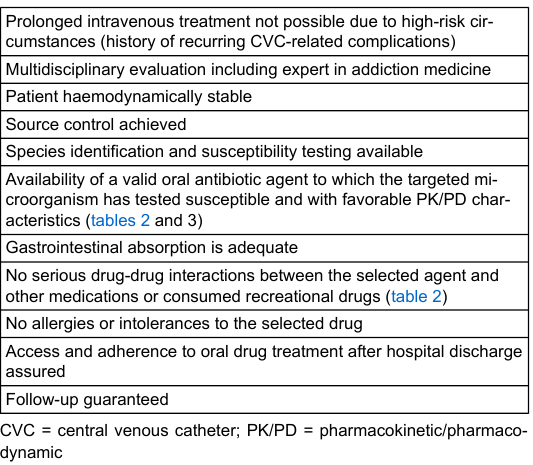
Table 1: Checklist for using oral antibiotics in PWID with bacteraemia.